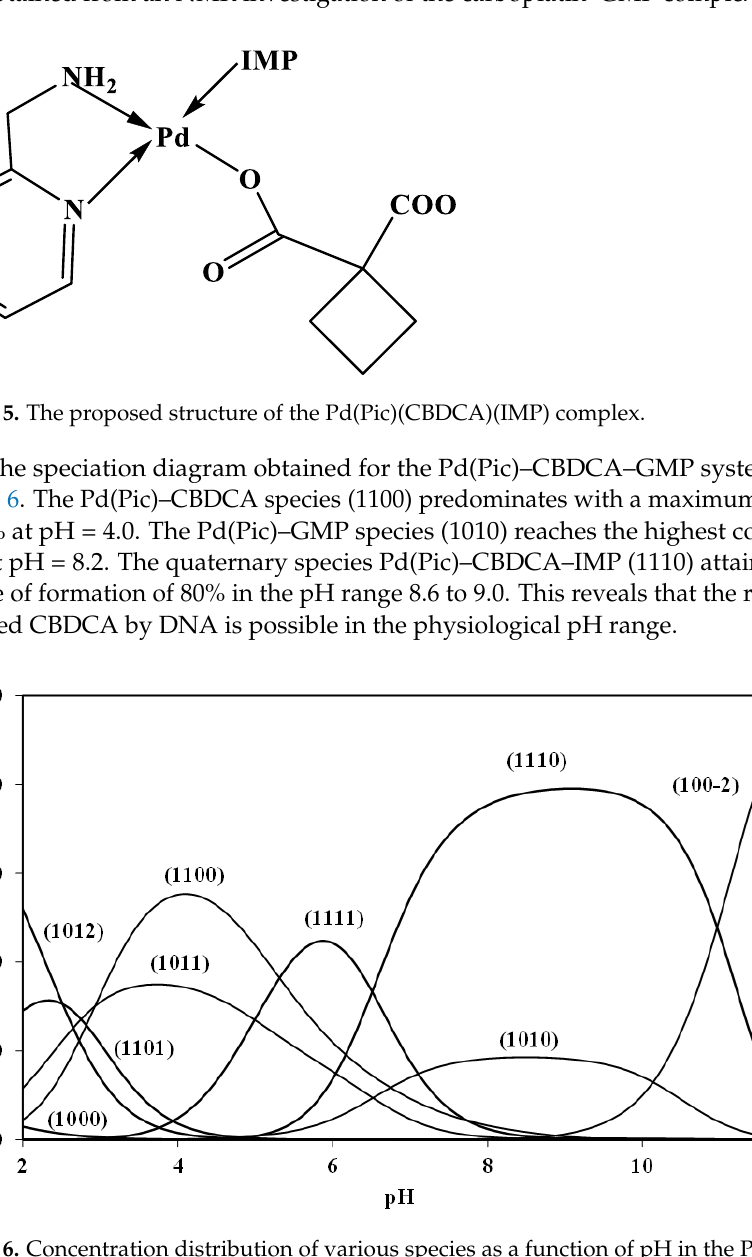
Figure 6. Concentration distribution of various species as a function of pH in the Pd(Pic) – CBDCA – GMP system. GMP